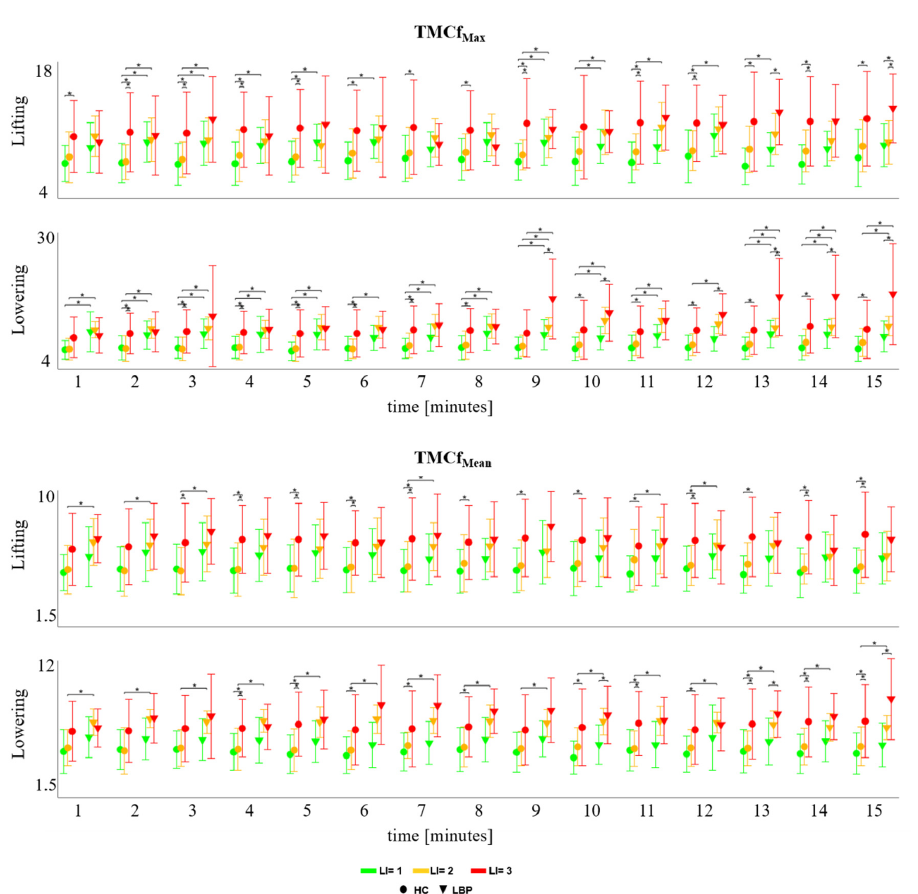
Figure 4. Mean ± SD for each risk level in both groups for the mean (TMCf Mean ) and the maximum (TMCf Max ) values of TMCf function considering all repetitions within each minute of lifting and lowering cycles. [* statistical significance ( p < 0.05)].